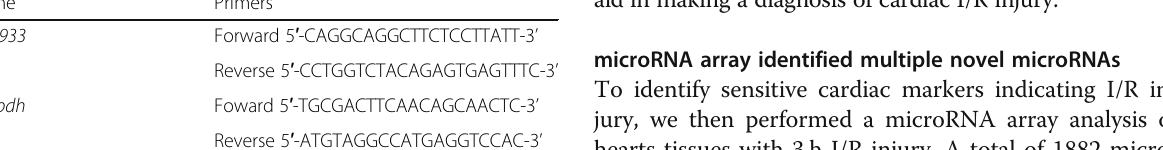
Table 2 Primer sequences for target genes Gene